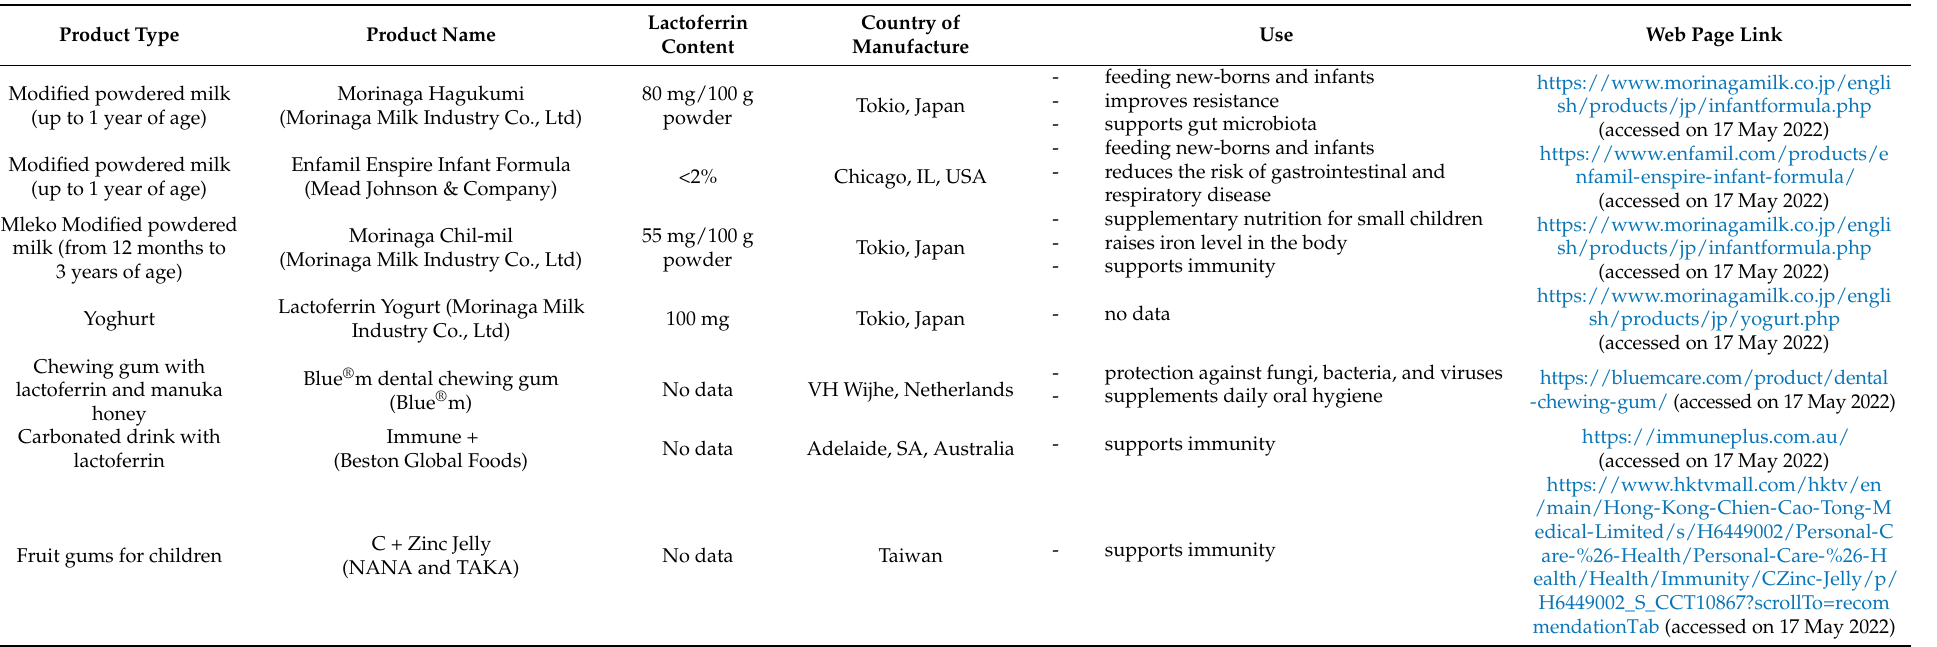
Table 7. Use of LF in food products (own